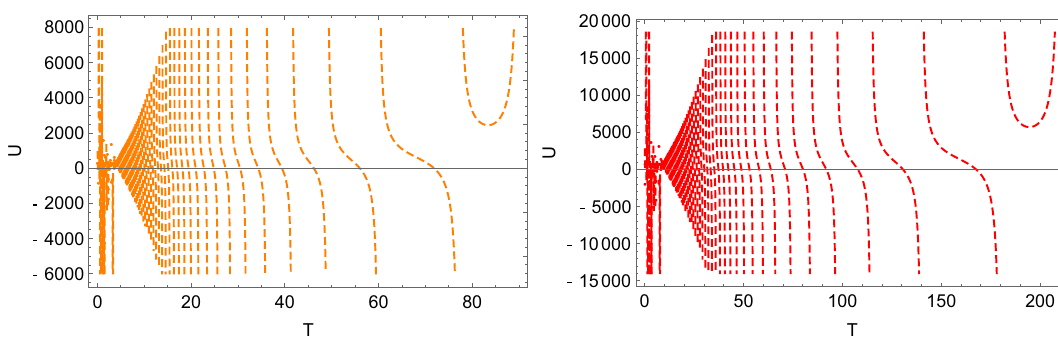
Fig. 2 Internal energy in terms of temperature with G = m = k = 1, and λ = 1 / 6